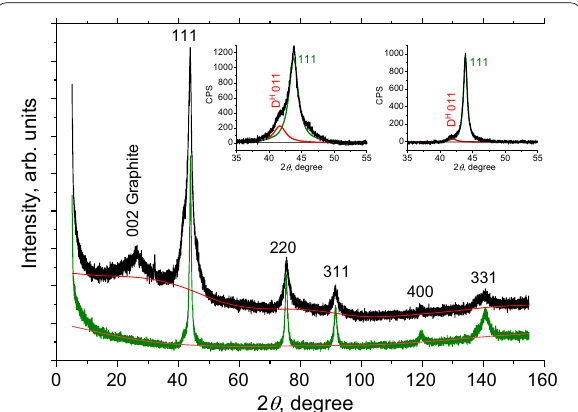
Fig. 3 Powder XRD profiles of the DP 0–0.05 fraction of polycrystalline diamond particles (black curve) and D19 nanodiamonds obtained by sintering (green curve). Insets: Fitting of the most intense reflection from planes (111) with two (red and green) Lorentzian curves centred at 41.5° (D H 011) and 43.8 o (D c 111) for samples before (left inset) and after sintering (right